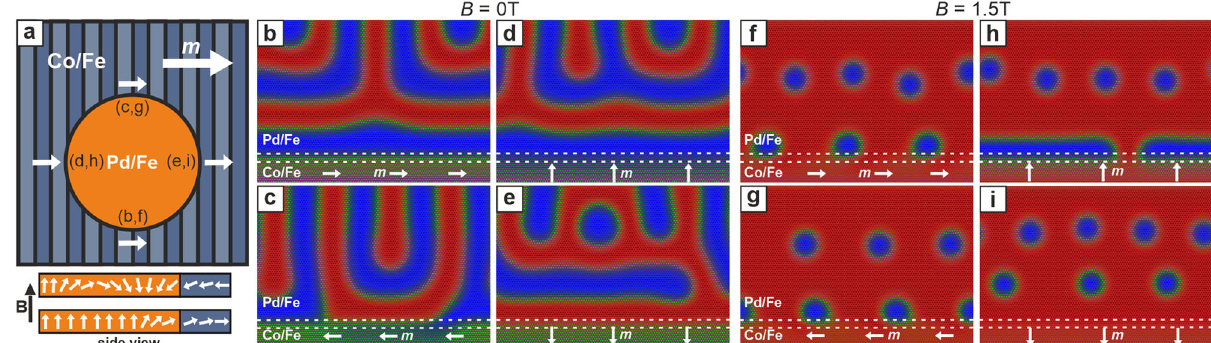
Fig. 7 Rotating the in-plane magnetization component in the reconstructed Co/Fe. a Schematic overview of the four magnetization directions and side view of a clockwise spin rotation at the edge with and without incorporating an edge-skyrmion. b – e Simulations at zero magnetic fi eld and f – i at B = 1.5 T. The hexagonal lattice has periodic boundary conditions in the horizontal direction and is split into three distinct areas with the magnetic parameters as shown in Table 1 with exchange interaction J = 2.86 meV/atom and Dzyaloshinskii – Moriya interaction D = 0.76 meV/atom in the pseudomorphic transition area. The white arrows indicate the in-plane magnetization component m of the reconstructed Co/Fe. Red and blue areas represent spins pointing in opposite out-of-plane directions, while in-plane pointing spins are pseudomorphic Co/Fe area. During the simulation, the skyrmion parameters in the pseudomorphic Co/Fe area. First, the strength was repelled from the Co/Fe edge and slowly moved further of the exchange interaction is reduced step-wise from 4.86 meV/ inside the Pd/Fe fi lm. To now investigate the role of magnetic atom to 0.86 meV/atom in Fig. 6a – f, while DMI is kept constant interactions at the Pd/Fe edge, we vary the strength of different at the same value as the adjacent Pd/Fe. When J is considerably